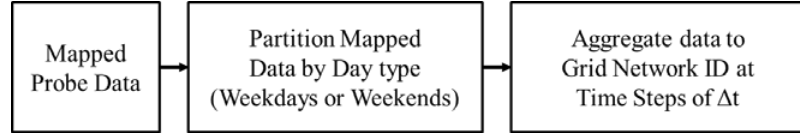
Figure 4. Flow diagram of a data aggregation process.